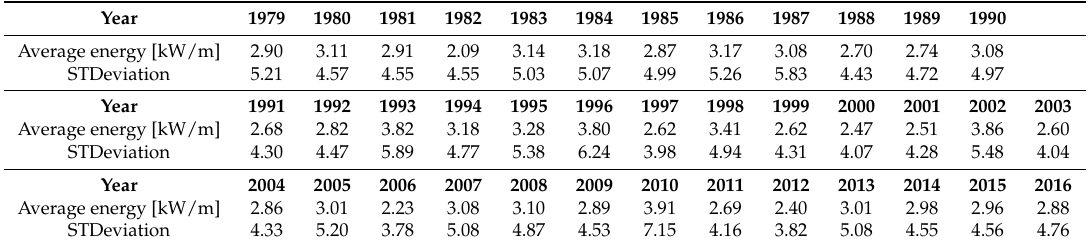
Table 4. Mean and standard deviation Pwave for each year of the data